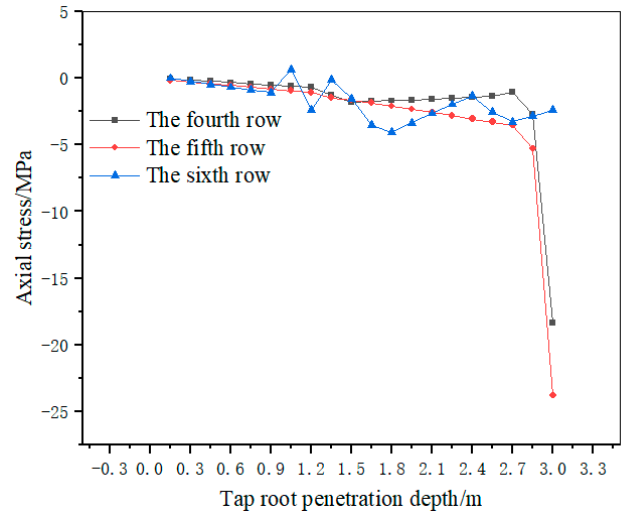
Figure 9. The fourth to sixth rows tap roots stress.